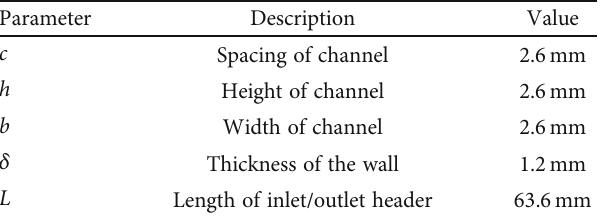
Figure 1: The schematic of regenerative cooling Table 1: Values of the geometric used in the simulation.